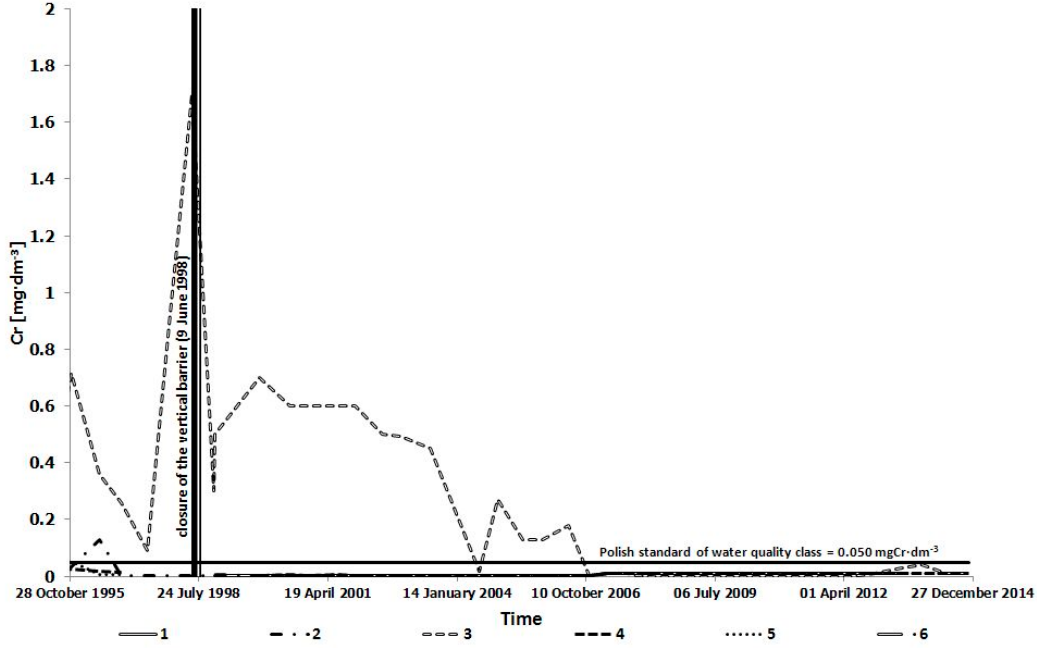
Figure 5. Changes of chromium concentration in groundwater on MSW Łubna Landfill surroundings during monitoring period 1994–2014.